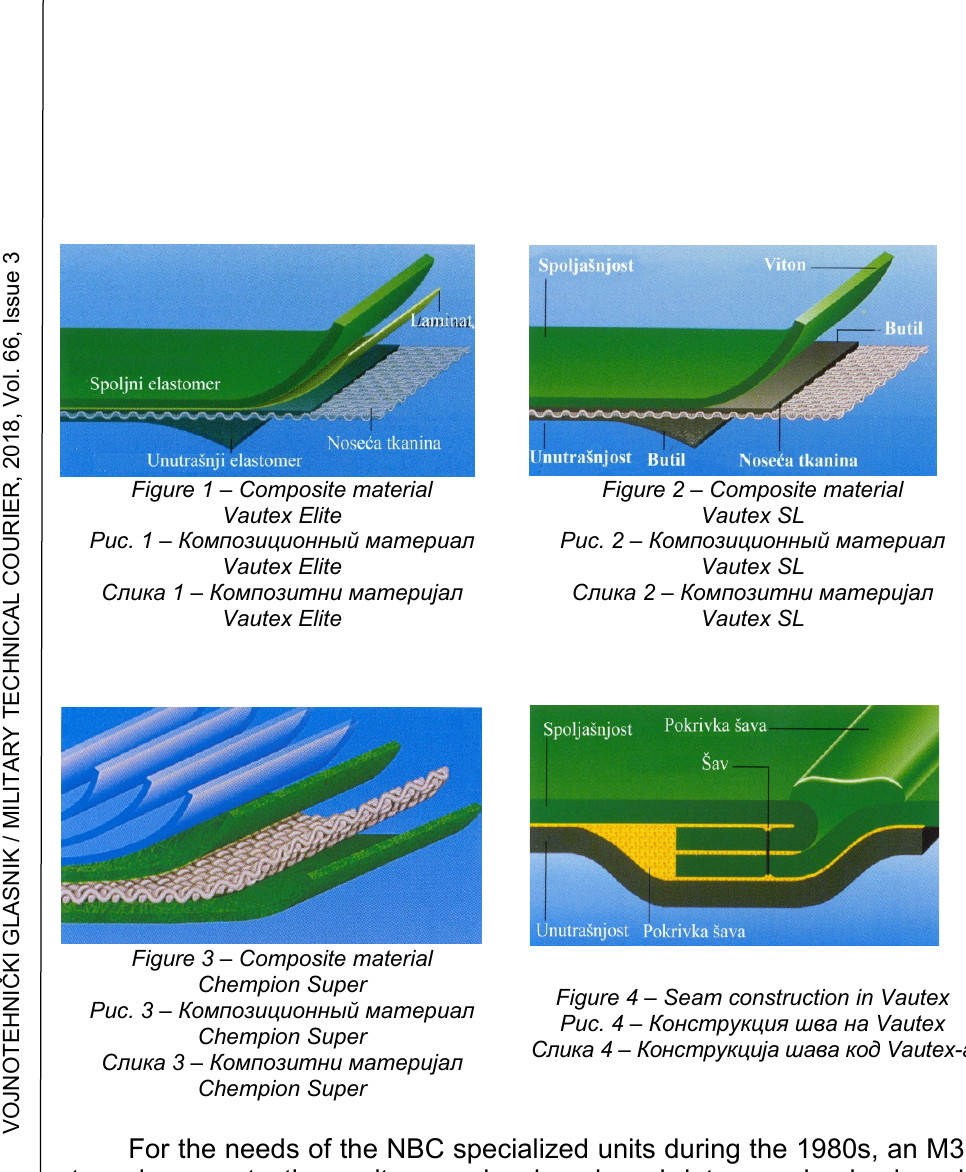
Figure 4 – Seam construction in Vautex Рис . 4 – Конструкция шва на Vautex Слика 4 – Конструкција шава код Vautex-